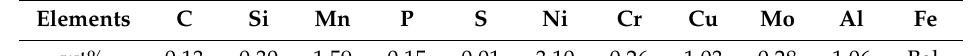
Table 1. Chemical composition of AISI P21 steel.